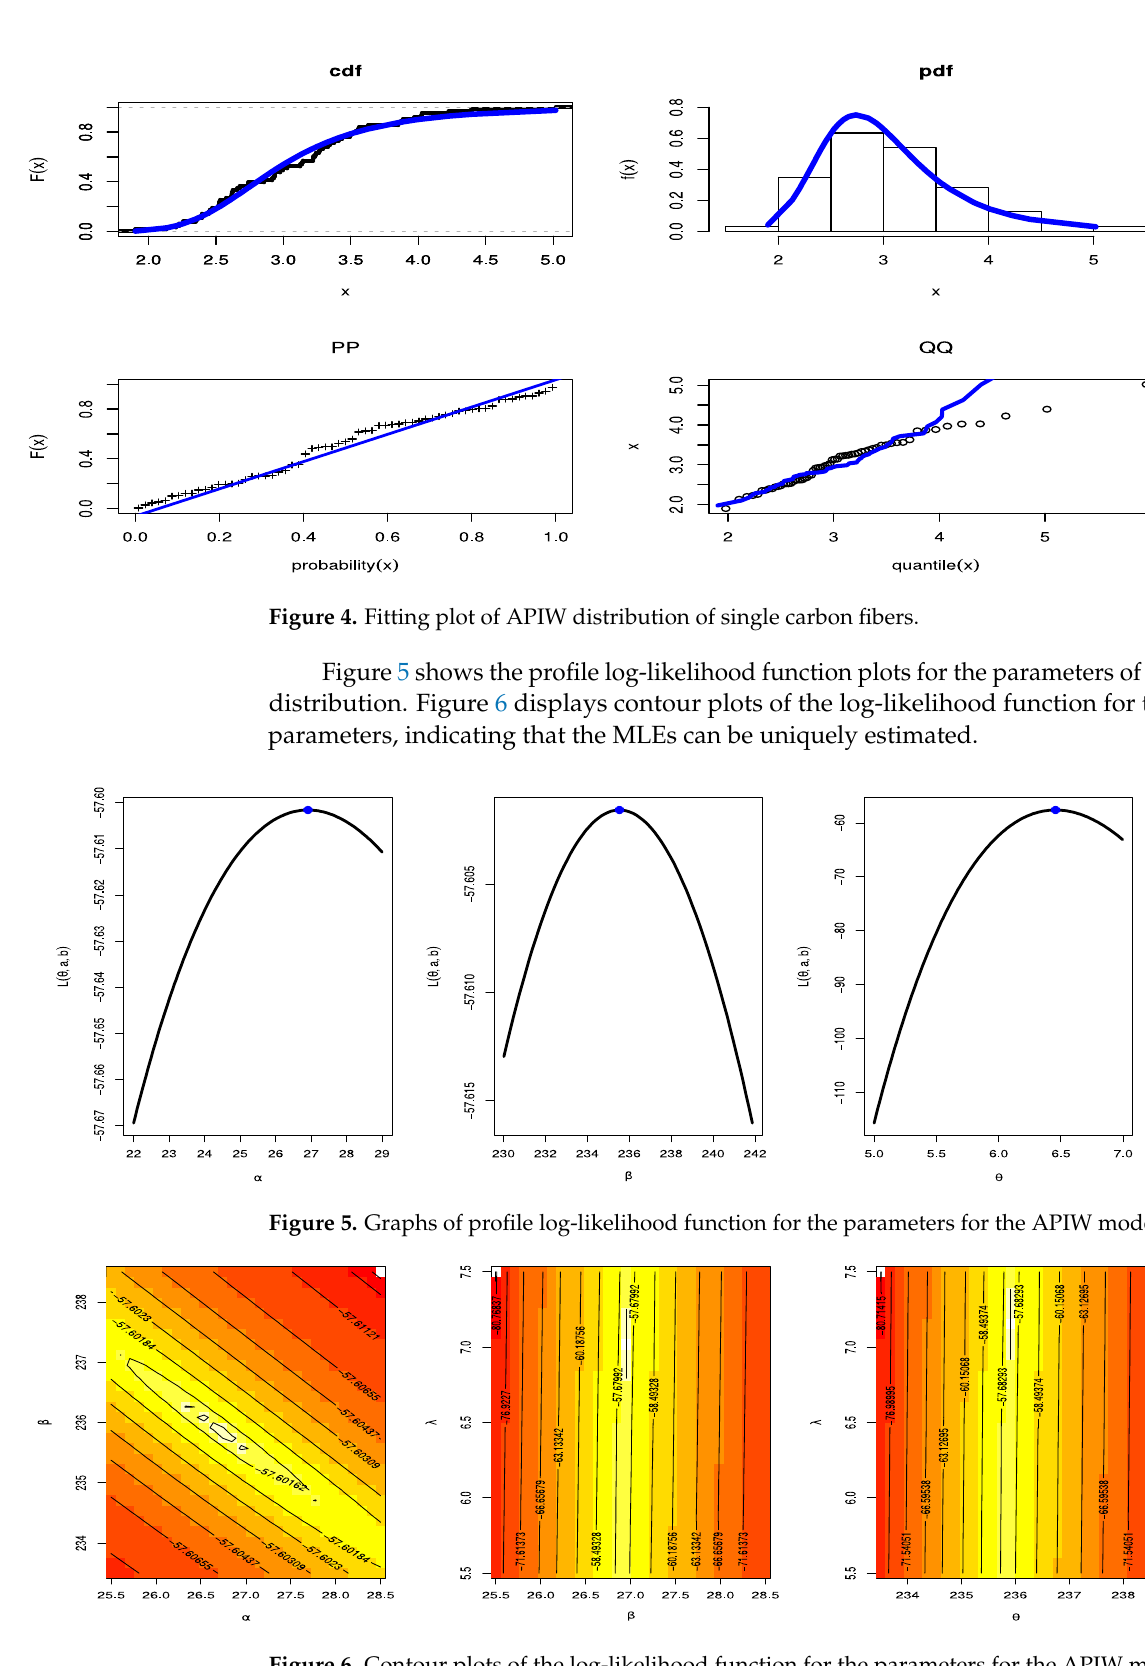
Figure 6. Contour plots of the log-likelihood function for the parameters for the APIW model.